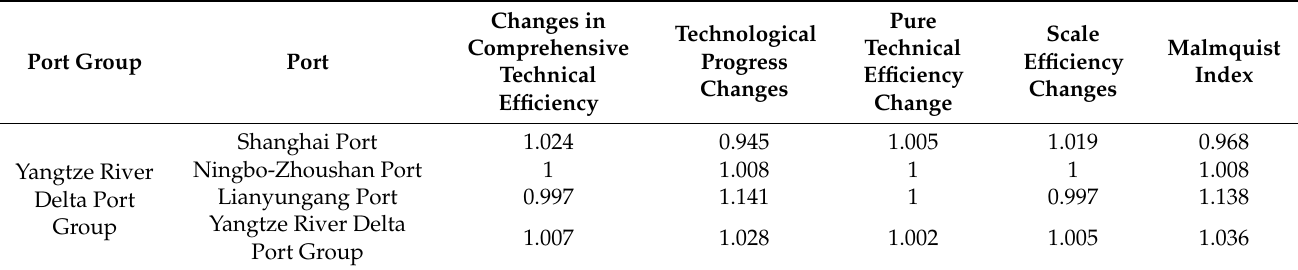
Table 8. The port group, the MPI value of each port and its